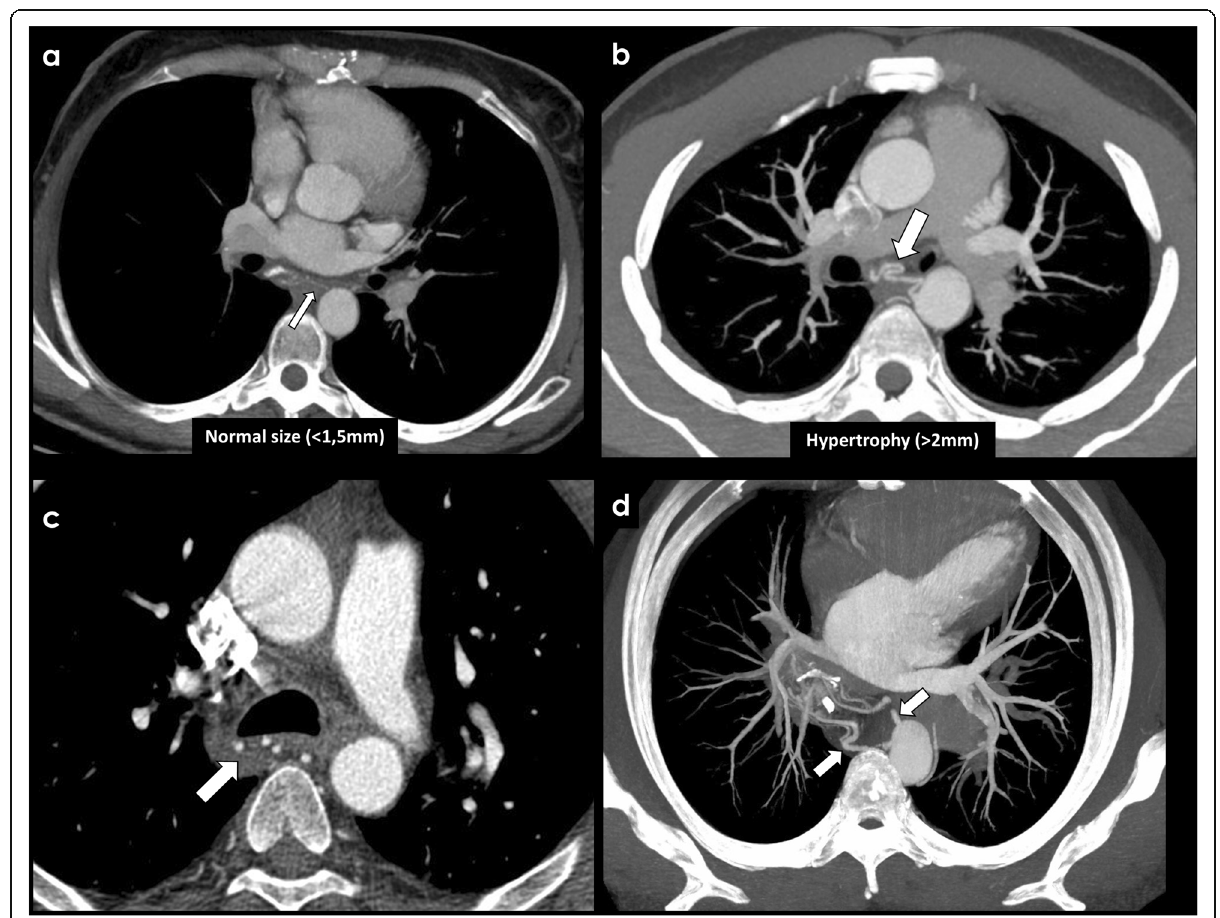
Fig. 3 Imaging of the bronchial arteries. CECT findings of normal bronchial arteries ( a , arrow), with a reduced caliber inferior to 1,5mm. The remaining images show a patient with hypertrophy of the bronchial arteries, with a caliber exceeding 2mm ( b , c , d ; arrows). MIP images ( b , d ) are useful when depicting small vessels like the bronchial arteries, displaying its tortuous course in a single image. The patient had a long-term history of